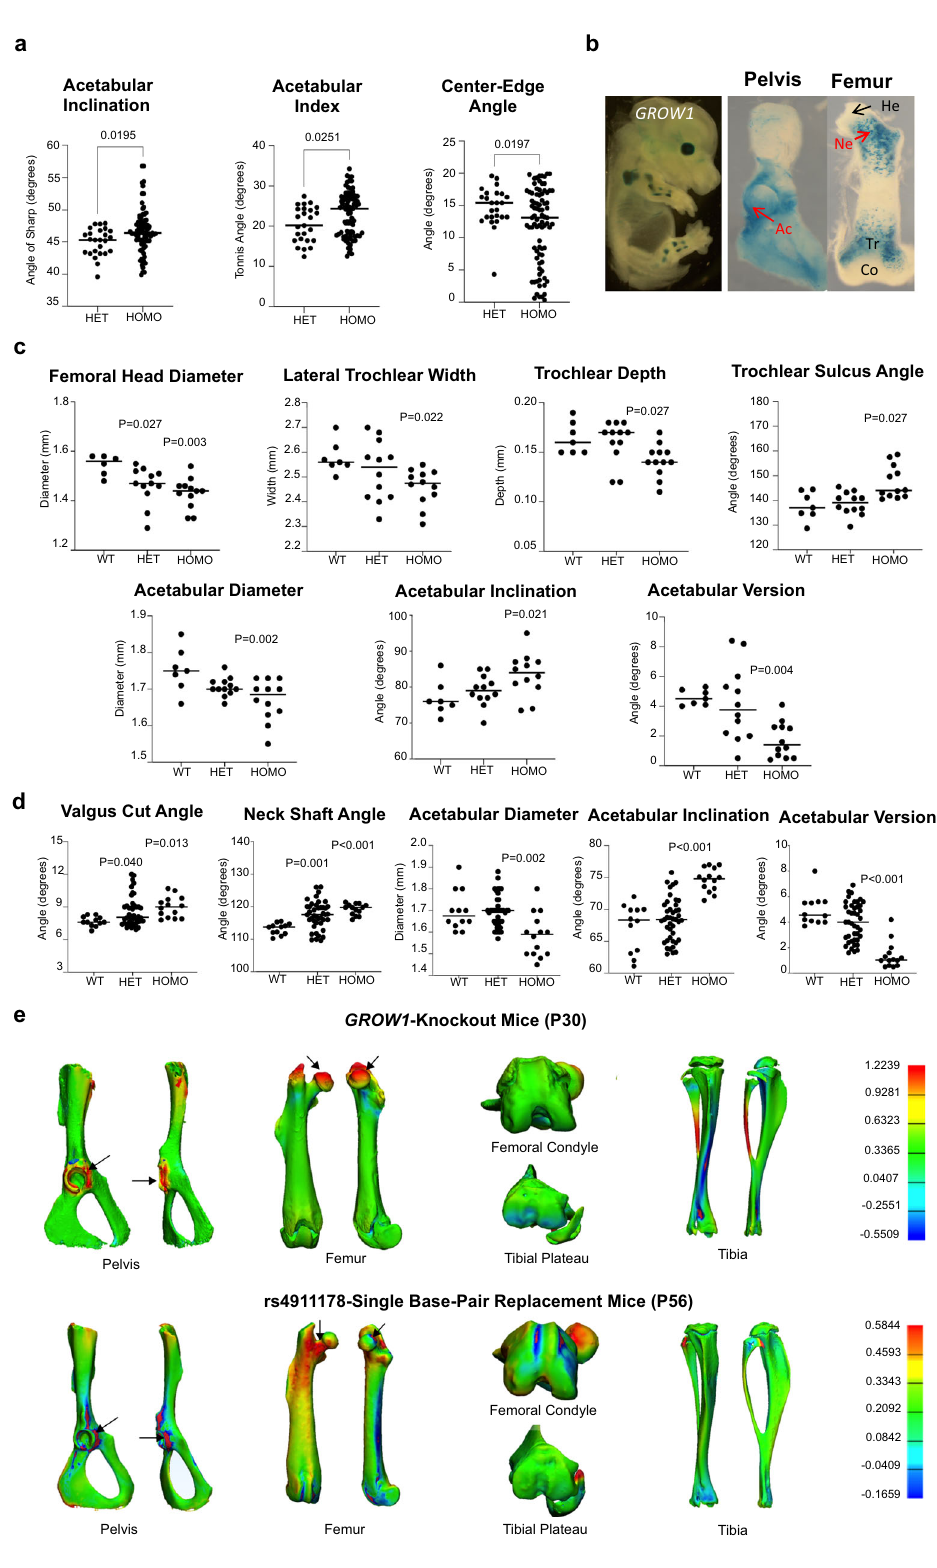
GROW1 rs4911178-A/rs4911178-G , harvested from the proximal p = 0.0034), distal femur (9.92-fold, n = 3, p = 0.0114), and femur, distal femur, and proximal tibia growth plates, to identify proximal tibia (6.03-fold, n = 3, p = 0.013) (Fig. 3g), which how PITX1 in fl uences Gdf5 expression in different structures of resulted in stimulated response for Gdf5 mRNA of 7-fold ( n = 3, the hind limb. The use of the PITX1-overexpression construct greatly increased the intracellular levels of PITX1 mRNA in p = 0.683) for the proximal femur, distal femur and proximal chondrocytes derived from the proximal femur (9.30-fold, n = 3, tibia, respectively (Fig. 3g). Using MiSeq on pulled-down NATURE COMMUNICATIONS| (2021) 12:4161